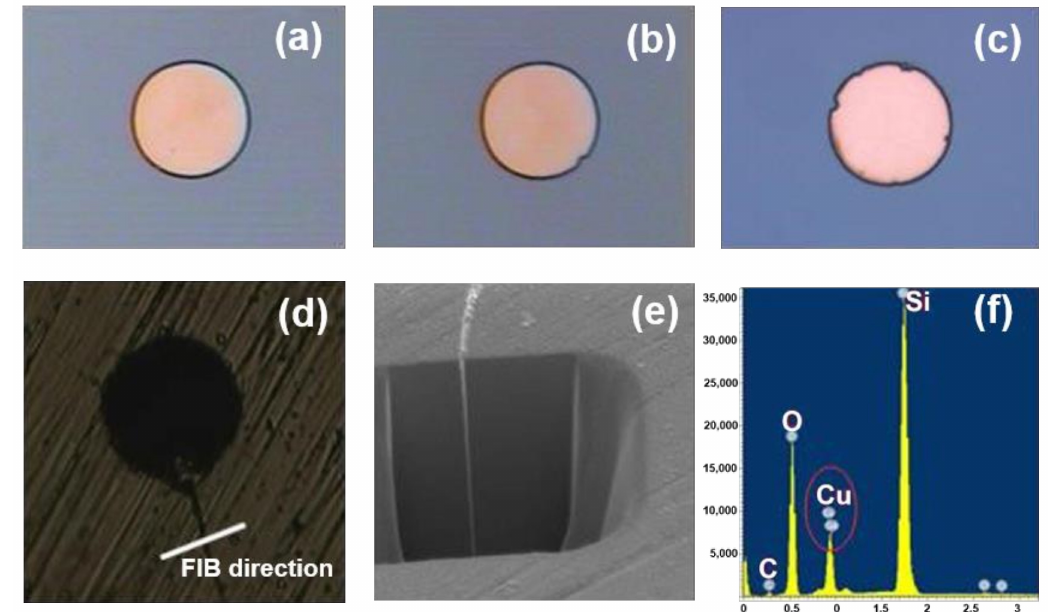
Figure 3. Optical images showing the TSV bottom from wafer backside of ( a ) good TSV sample and ( b , c ) non-ideal TSV sample. ( d ) A crack observed from a TSV sample, the ( e ) FIB cross-section, and ( f ) EDX analysis results.